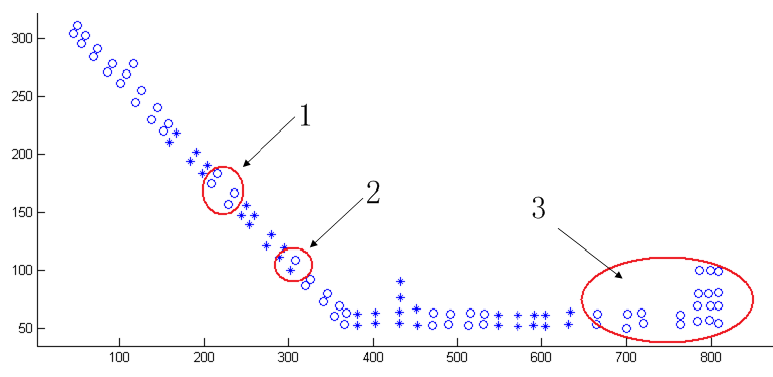
Figure 6. APC classification results.